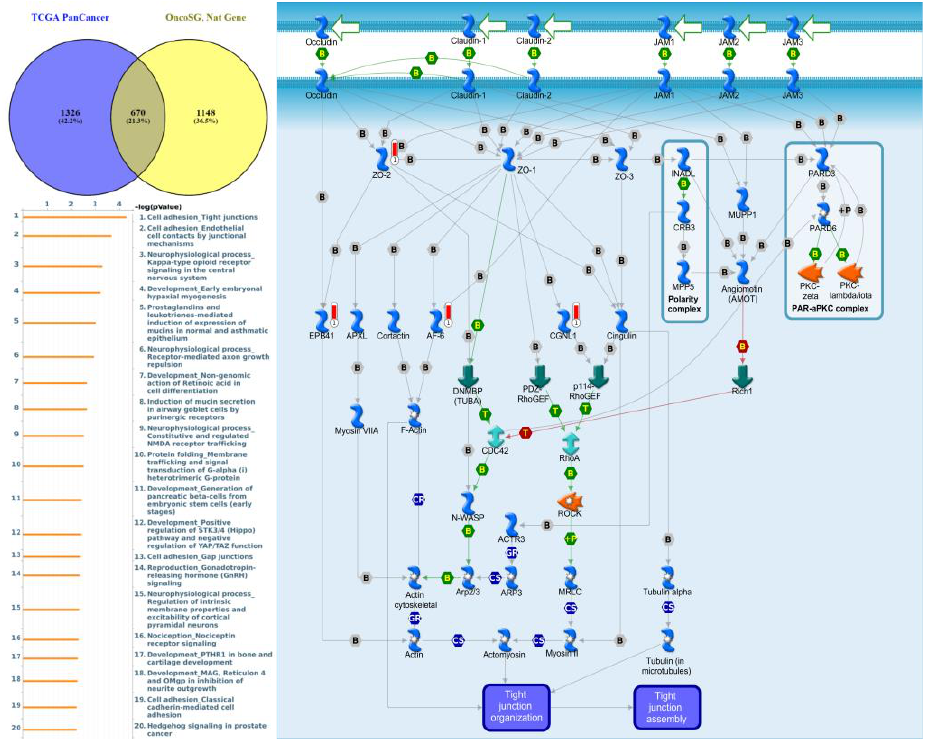
Figure 7. Expression of the protein tyrosine phosphatase non-receptor type 3 (PTPN3) signaling pathway in lung cancer (from Metacore). The functional analysis of “Cell adhesion_Tight junctions” was correlated with lung cancer development.